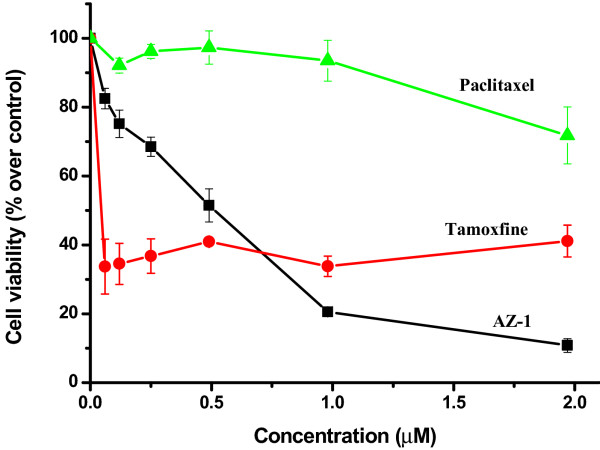
Comparison of the death effect of BC-M1 cells induced by various concentrations of bis-aziridinylnapthoquinone (AZ-1), paclitaxel and tamoxifen by the MTT assay. The MTT assay was used to determine the cell viability after an additional 24 hours of culture. Data are from quadruplet wells and are representative of three separate experiments.